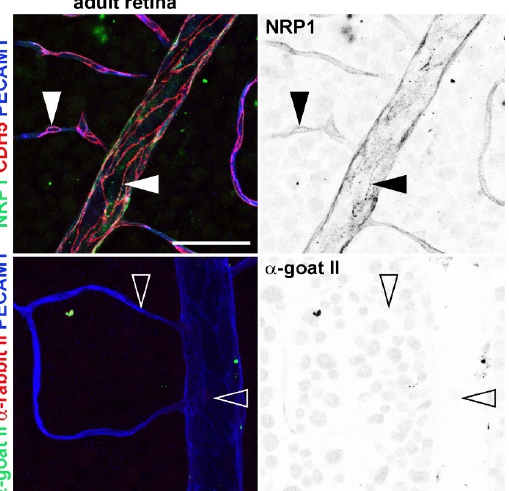
Figure 2. Whole-mount immunostaining of the superficial plexus of adult mouse retina for NRP1, the adherens junction protein CDH5 (VE-Cadherin) and the adhesion molecule PECAM1 (top panels). The panels at the bottom show immunostaining for the same markers but omitting the primary antibody for NRP1 and CDH5. The panels on the right show the green channels as inverted black and white. Arrowheads indicate examples of endothelial junction sites enriched for NRP1 in capillary and venules (top panels) and similar sites in the no primary control (bottom panels). Bar, 50 μ m.